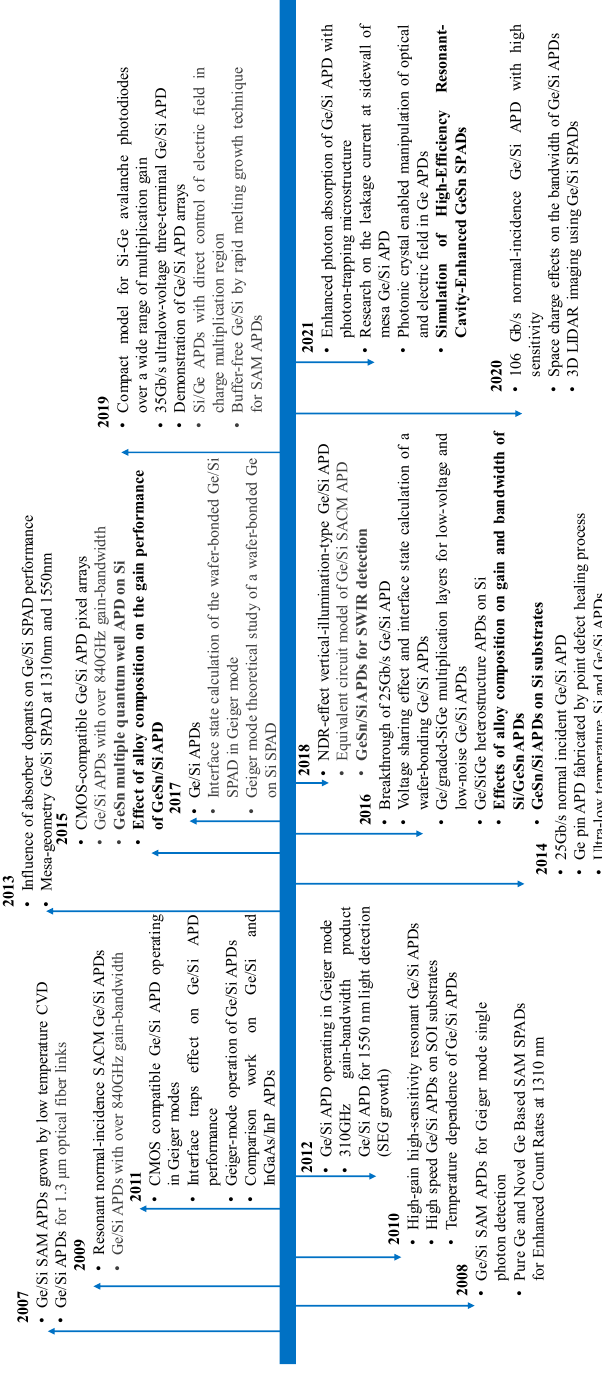
Figure 8. Research development of Ge(GeSn)